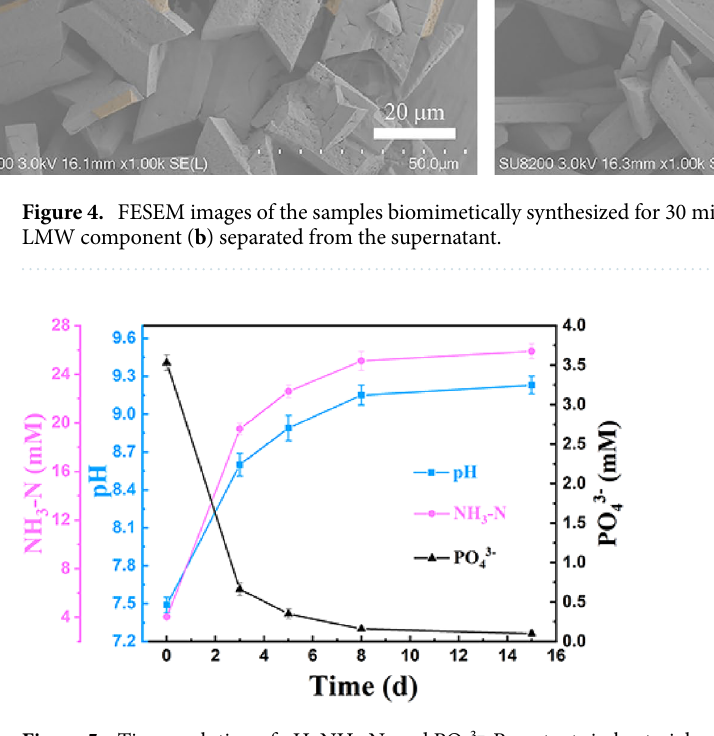
Figure 5. Time evolution of pH, NH 3 -N, and PO 4 3− -P contents in bacterial mineralization